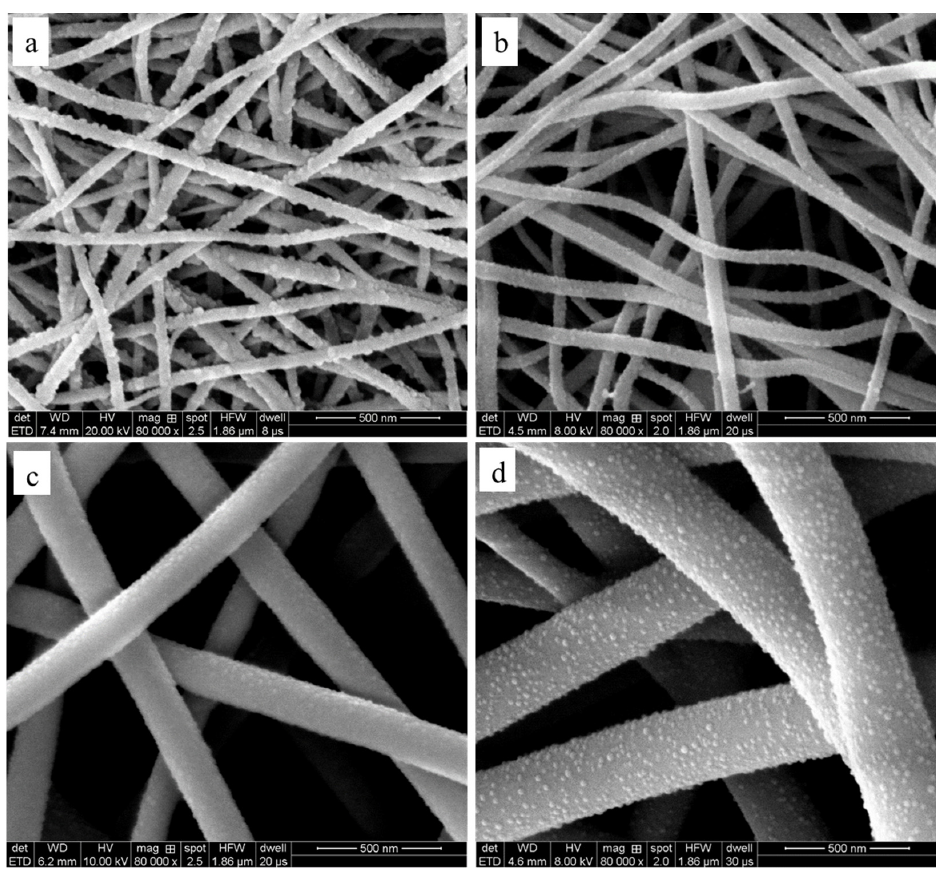
Figure 8. SEM images of the reduced catalysts made from the solution with di ff erent metal ion contents: